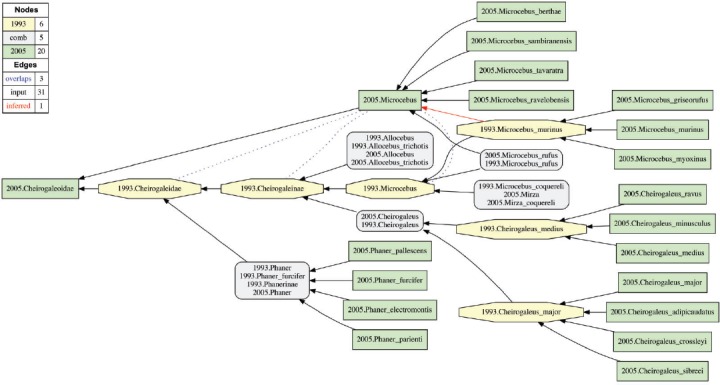
Visualization of the consistent, well-specified Cheirogaleiodae sec. Groves (2005)(T2) / Cheirogaleidae sec. Groves (1993)(T1) alignment; see also Figures 1 and 2.